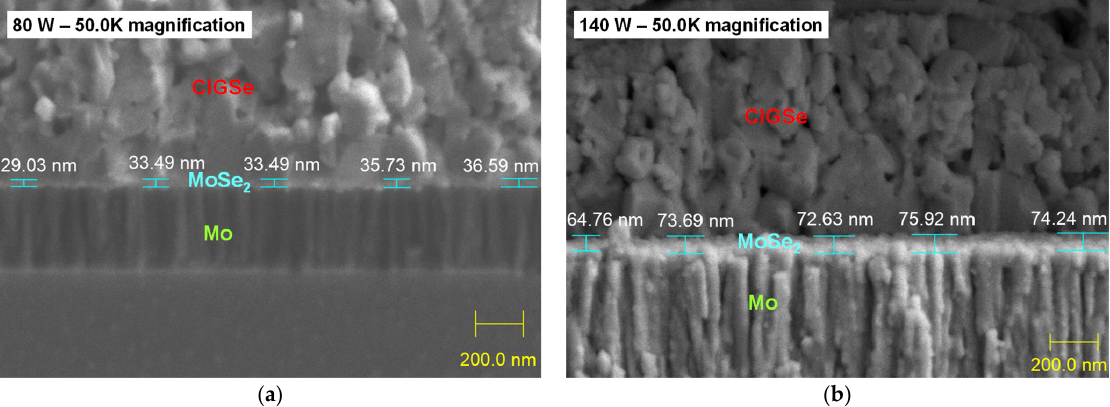
Figure 6. Cross-sectional view of CIGSe/Mo films annealed in Se-free atmosphere for sputtered Mo at different DC powers: ( a ) CIGSe on Mo film deposited at 80 W; ( b ) CIGSe on Mo film deposited at 140 W. Table 4. Hall effect measurement results of Mo thin films.